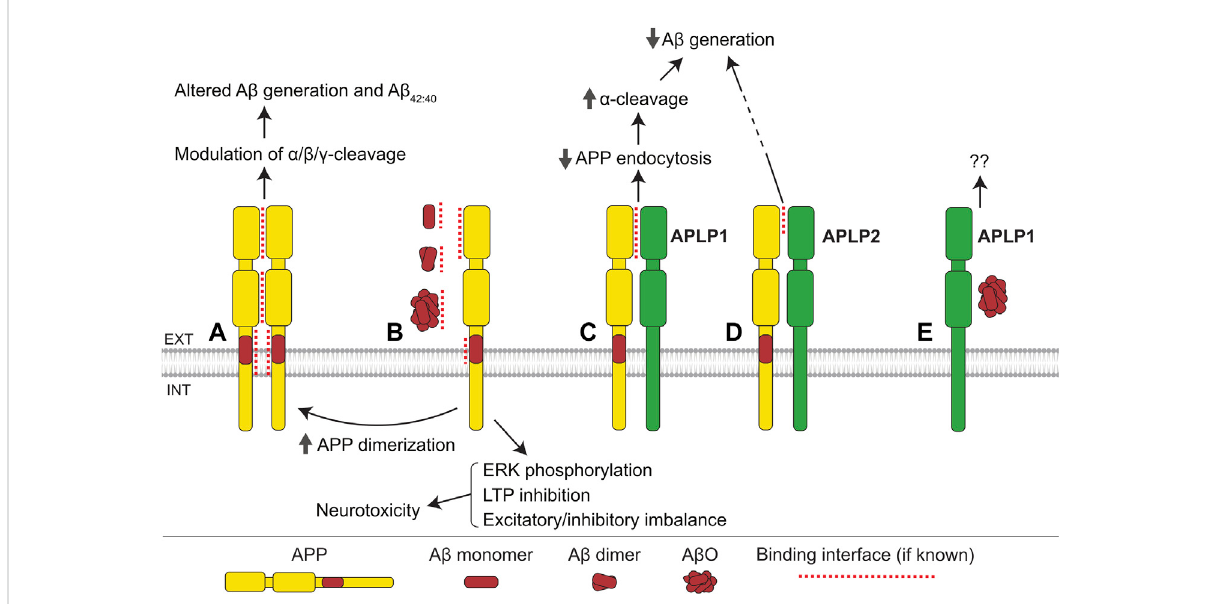
FIGURE 2 APP family interactions. (A) Interactions between E1, E2, and transmembrane domains of APP mediate formation of homodimers. Homodimerization in fl uences the α -, β -, and γ -cleavage of APP, A β generation, and the ratio of A β 42/40 . (B) Monomers, dimers, and oligomers of A β bind to the E1 domain and cognate A β region of APP. The interaction with A β monomers and dimers promotes APP homodimerization, while the APP-A β O interaction induces ERK phosphorylation, inhibits long-term potentiation (LTP), and leads to excitatory/inhibitory imbalance, ultimately resulting in neurotoxicity. (C) APLP1 interacts with the E1 domain of APP, suppressing APP endocytosis, increasing cell surface levels of APP, and thereby facilitating the α -cleavage of APP, and consequently reducing A β generation. (D) APLP2 interacts with APP and reduces A β generation via an unknown mechanism. (E) APLP1 interacts with A β Os with unknown